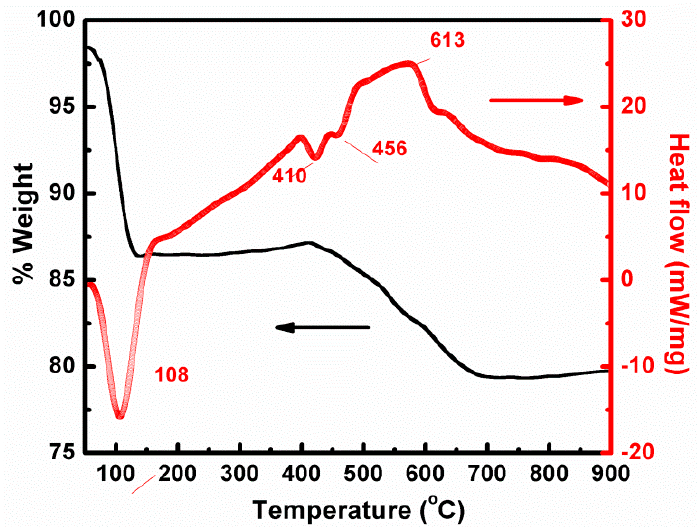
Figure 2. TG-DSC profile of: ( a ) ternary metal oxides and ( b ) LiOH—ternary metal oxide mixture under air atmosphere.